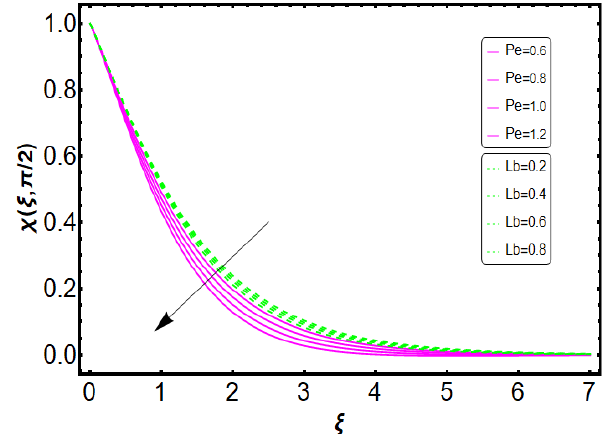
χ χ for P e and L b . for P e and L b .